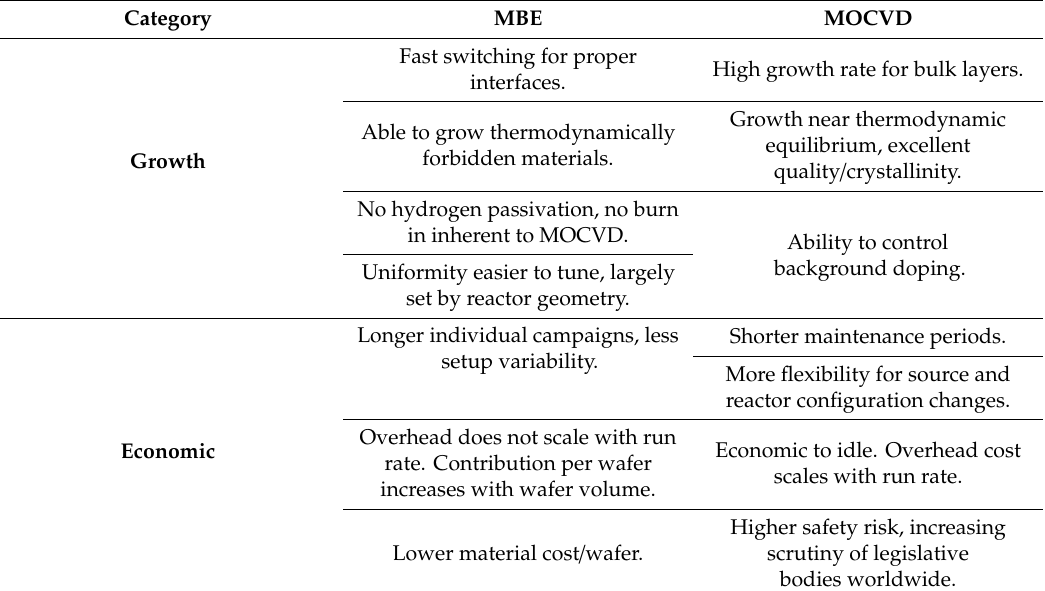
Table 1. MOCVD and MBE methods comparison (after